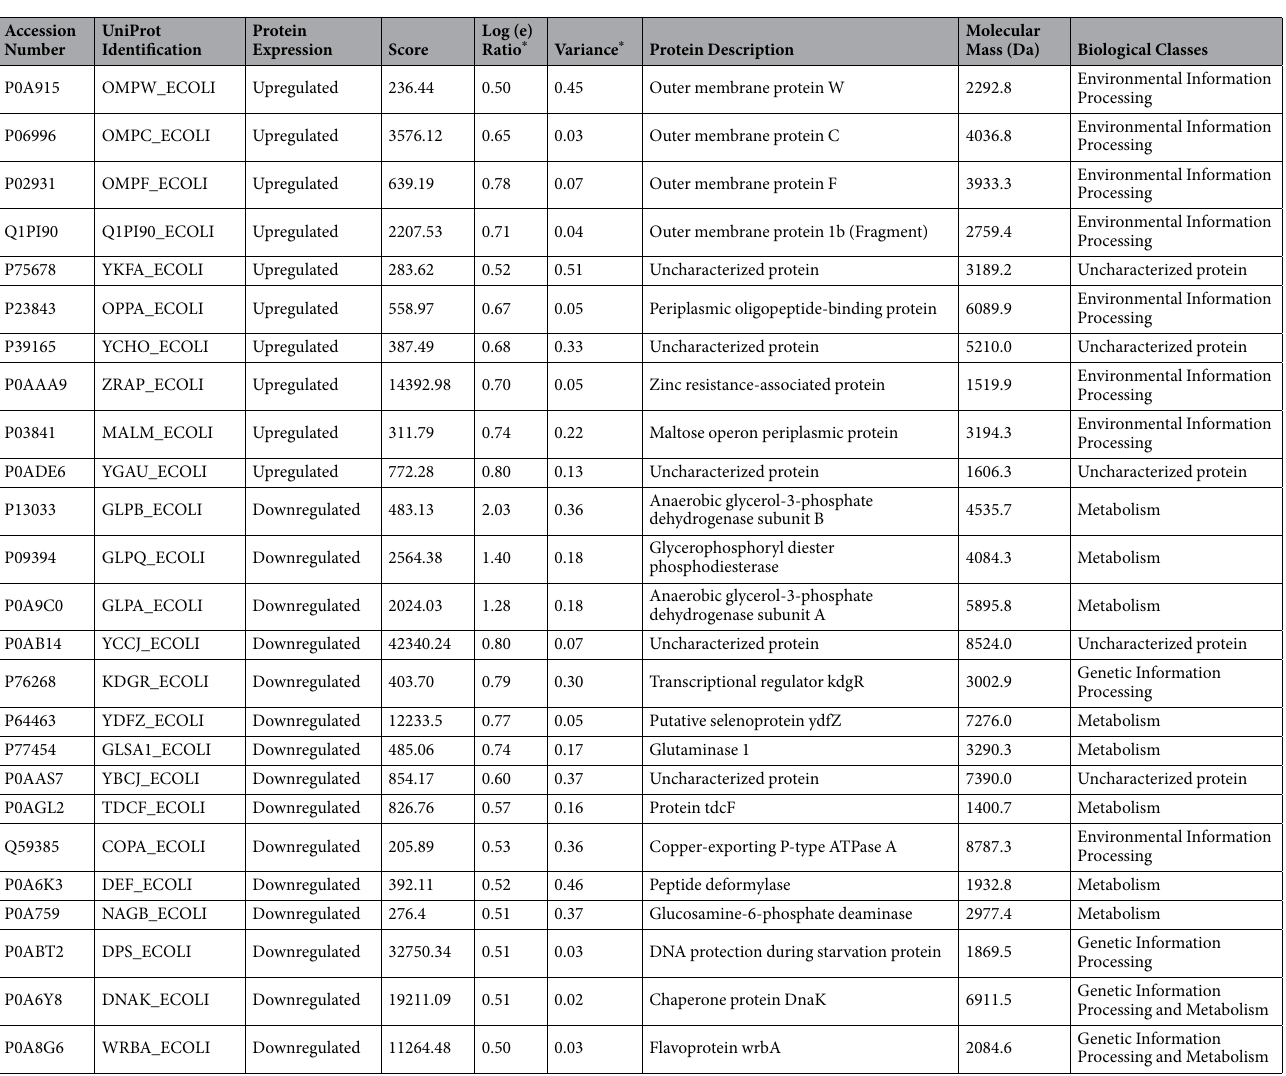
Table 1. Comparison of protein expression between magainin I-susceptible and magainin I-resistant Escherichia coli strains identified via nanoUPLC-MS E and their participation in the bacterial biological process. * Protein differential expression was considered significant in a Log(e) ratio ≥ 0.5 and a variance value ≤